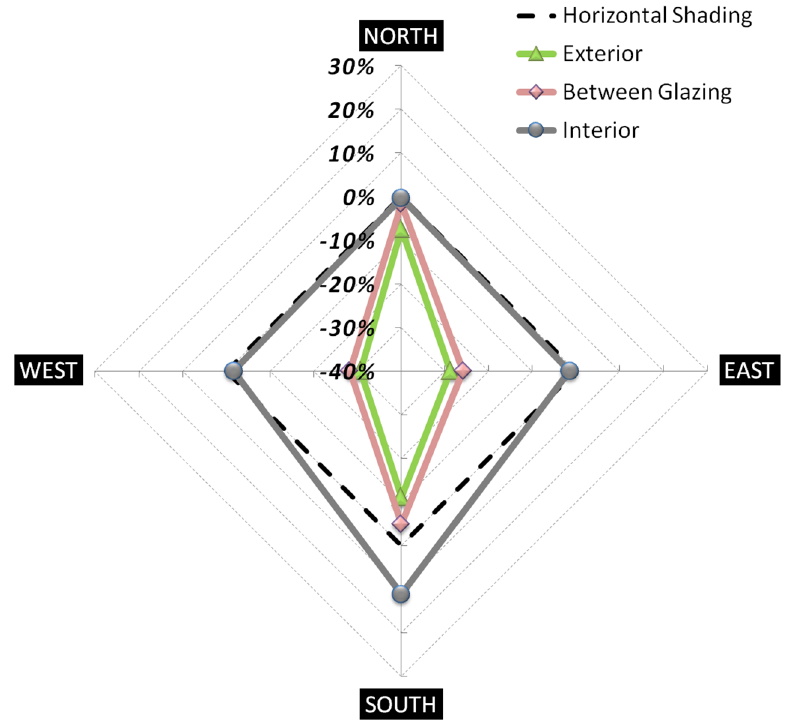
Figure 11. Saving ratio of heating and cooling load according to the type of shading (WWR 60%, U-value: 2.1, SHGC: